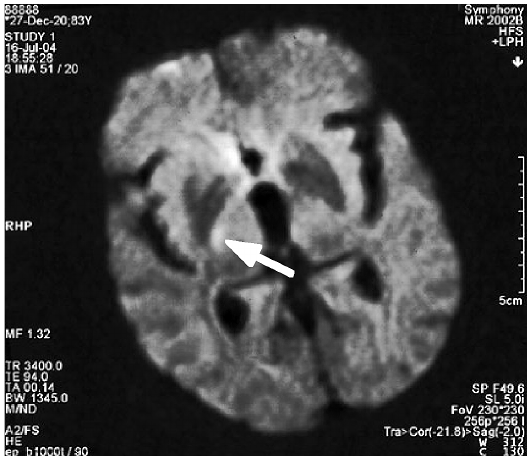
Figure 2 DWI lesion in a TIA mimic. DWI shows a mild signal increase in the right internal capsule of a patient with transient left hemiparesis attribut- able to hypogly-